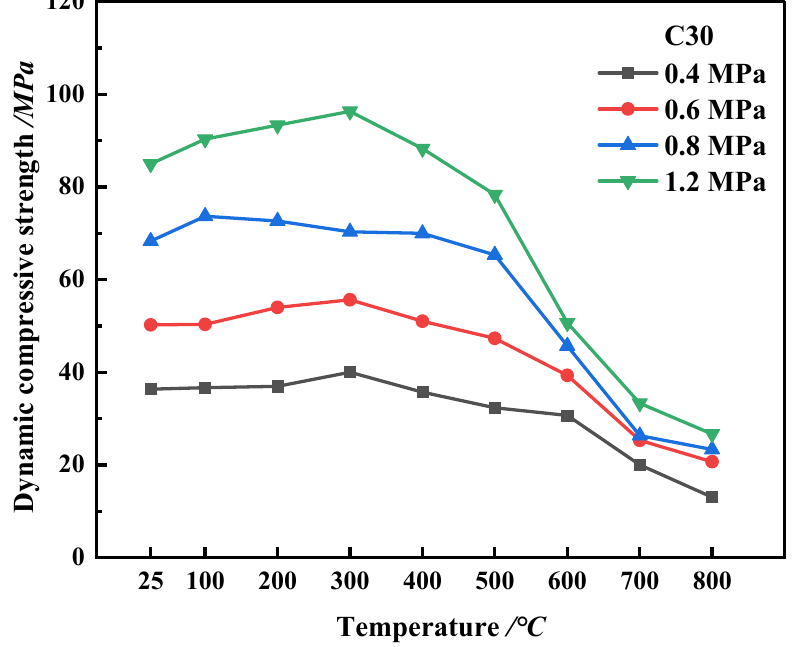
Figure 10. Stress–strain curves for HPC (C50) under various loading rates with a high temperature of 300 °C.